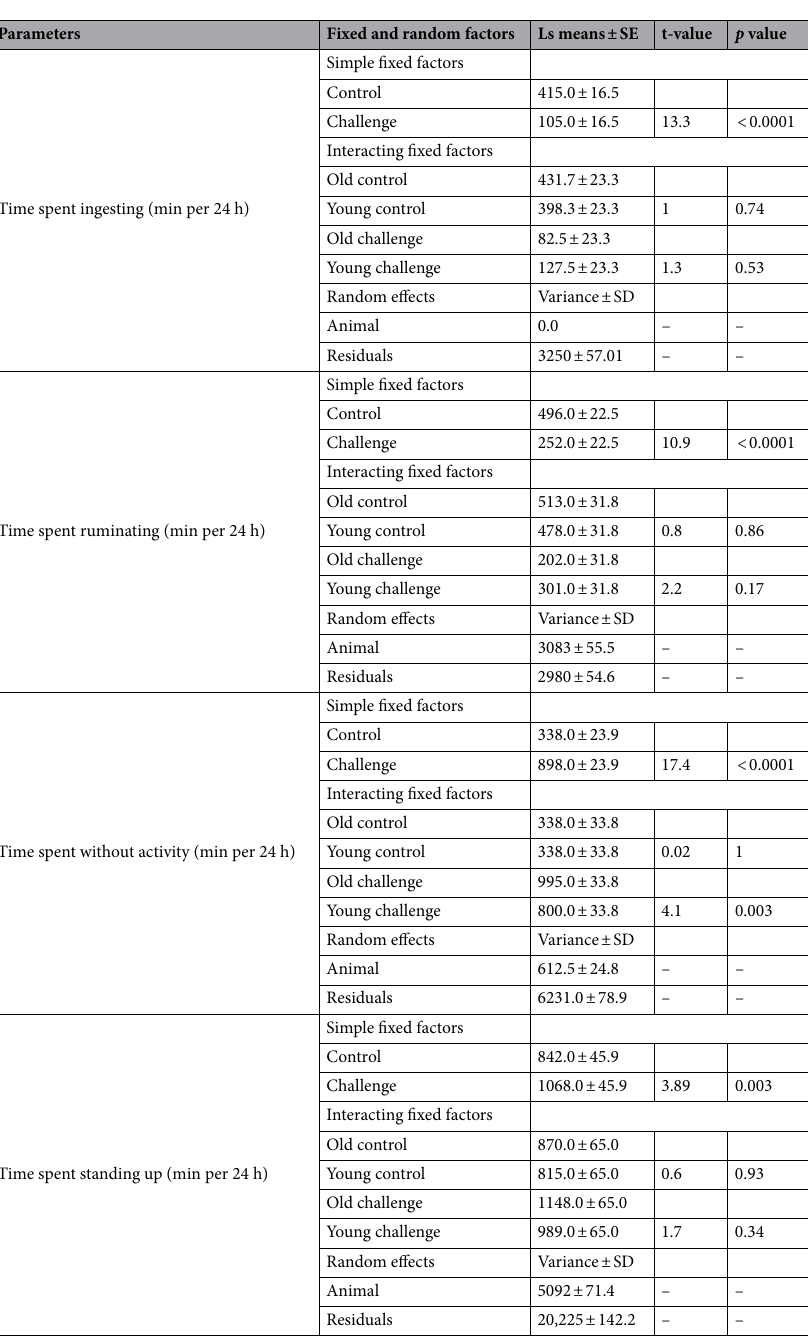
Table 3. Least squares (Ls) means in minutes ± Standard Error (SE) and Tukey-adjusted p-values from linear mixed-effect models of time spent ingesting (min), time spent ruminating, time spent without activity, and time spent standing up over 24 h (daily analysis) stratified by situation (CHALLENGE vs. CONTROL), and interaction between age (old vs . young) and situation, in 6 old and 6 young Holstein cows intravenously injected with LPS (0.5 µg/kg of BW) at